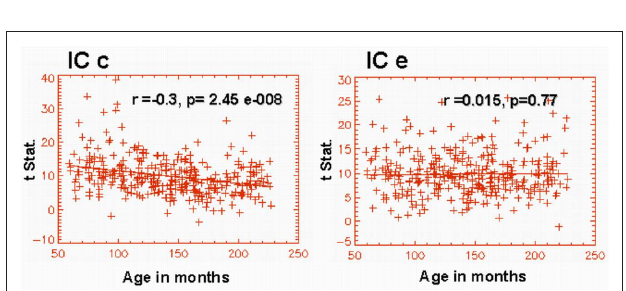
FIguRe 4 | graphical representation of the age dependence of functional connectivity between left and right hemispheres corresponding to IC maps shown in Figures 1C,e. IC c exhibits a highly significant functional connectivity between the left and the right inferior